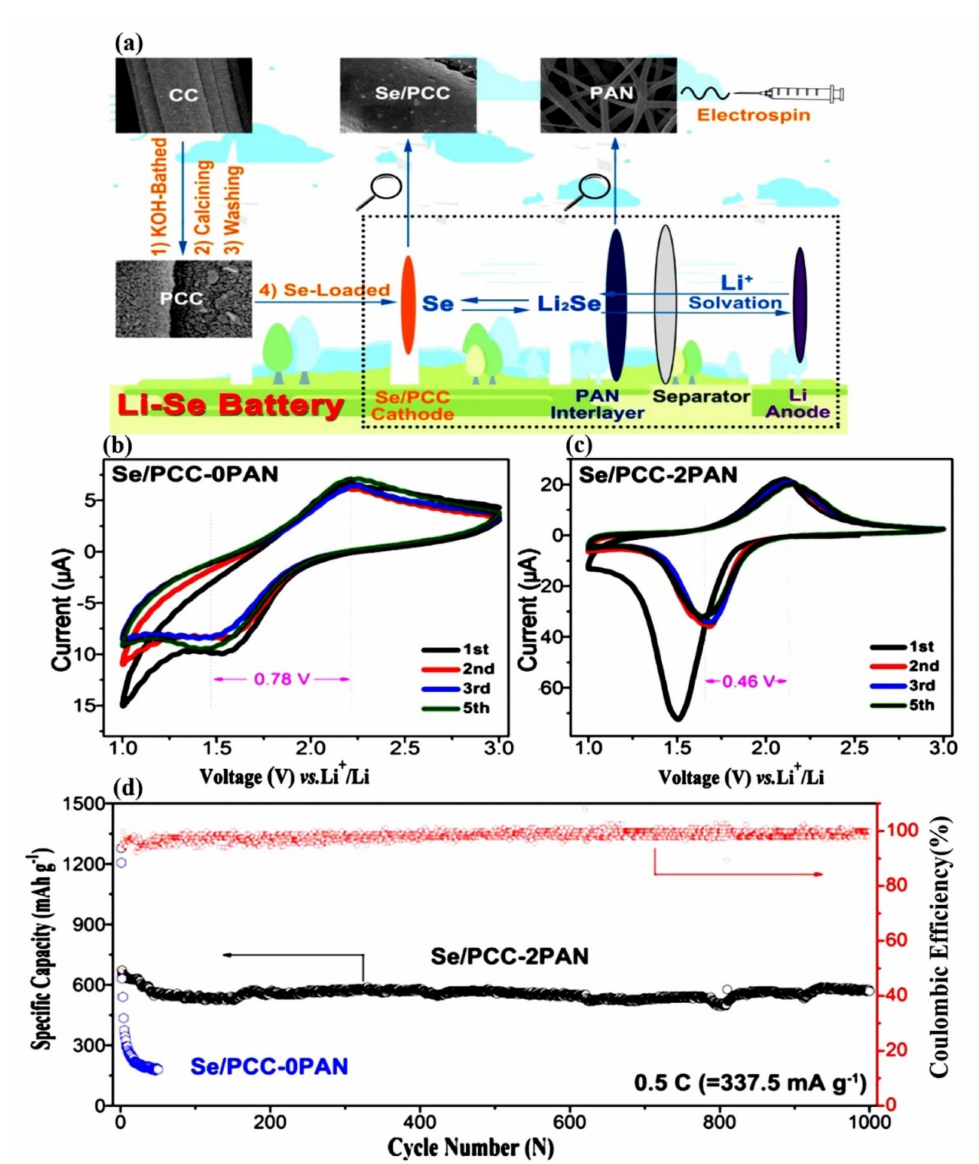
Figure 9. ( a ) The preparation process for the Se/PCC cathode and PAN interlayer, and the brief model of the assembled Li-Se battery ( b , c ) CV curves at 0.1 mV s − 1 and ( d ) cycling performances of the Se/PCC-2PAN and Se/PCC-0PAN systems at 0.5 C. Reproduced with permission from [85], Copyright 2019, American Chemical